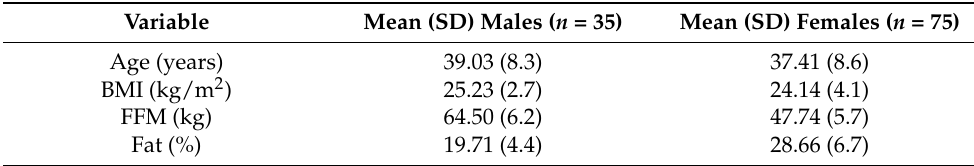
Table 1. Comparison of males vs. females in body